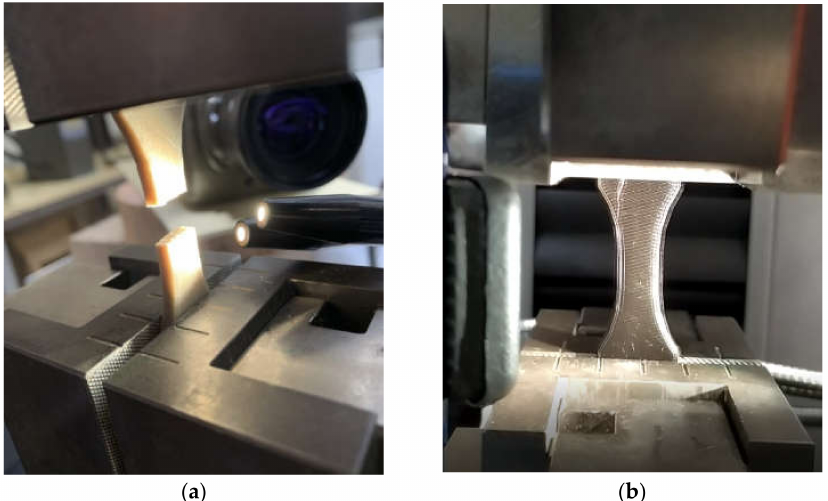
Figure 2. Experimental setup showing the tensile testing configuration with an optical camera and arc lamp light source for high-speed recording: ( a ) PLA-flax ruptured sample; ( b ) Illuminated PLA prior testing showing the filament